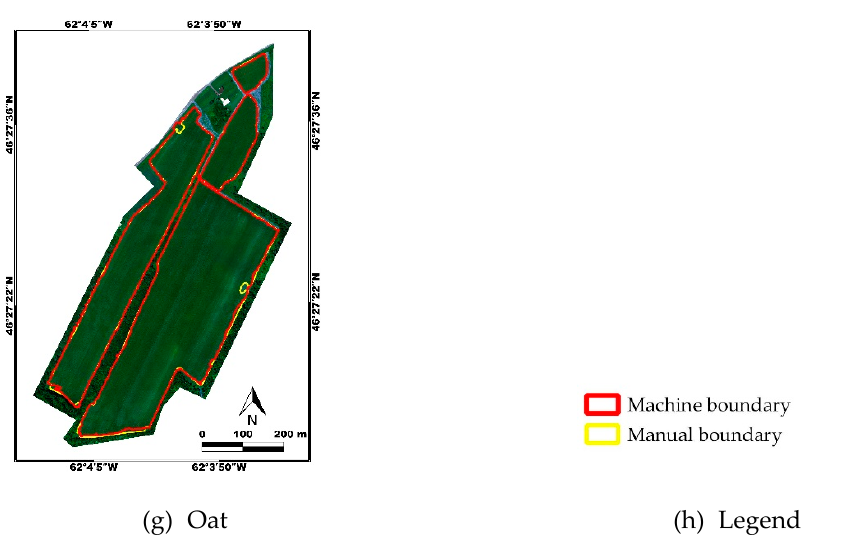
Figure 7. RGB image composites comparing the manually-delineated and GEOBIA-delineated borders for the following fields: ( a ) Barley1, ( b ) Barley2, ( c ) Barley3, ( d ) Corn1, ( e ) Corn2, ( f ) Corn3, ( g ) Oat; ( h ) Legend. The manually delineated borders are represented in yellow. The machine delineated borders are represented in red.